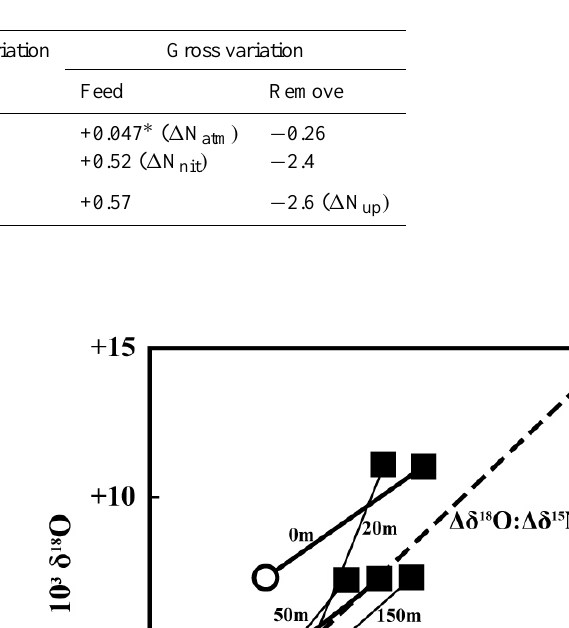
Table 2. Variations in the total inventory of nitrate (N total ) in Lake Mashu, together with those of atmospheric nitrate (N atm ) and rem- ineralized nitrate (N re ) . Each net and gross variation are presented as well, together with gross variation in atmospheric nitrate through depositions ( 1 N atm ) , remineralized nitrate through nitrification ( 1 N nit ) , and nitrate uptake through assimilation ( 1 N up ) in the lake during the observations. All units are in MmolN.